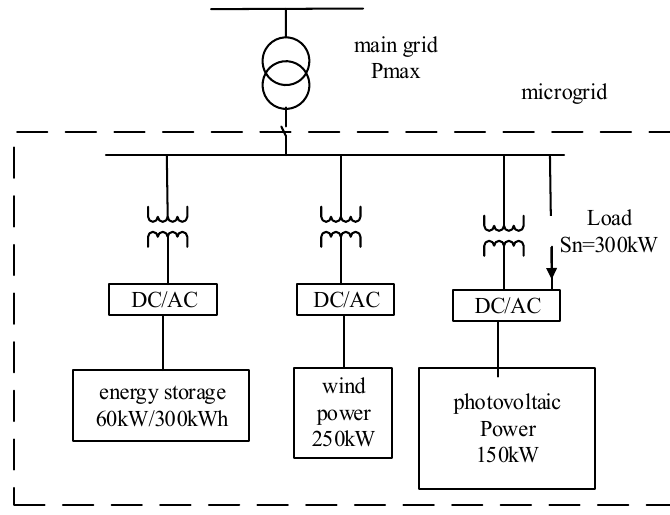
Figure 1. Simplified structure diagram of microgrid system.